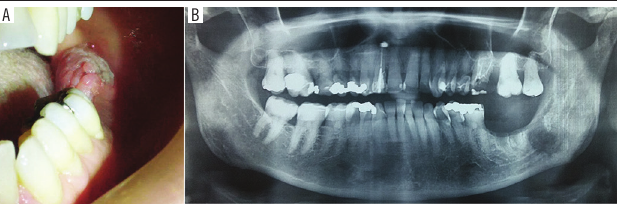
figurE 1 − A) exophytic mass located at the left mandibular gingiva. Previous dental extraction and chronic suppurative osteomyelitis were noticed in this area; B) panoramic radiograph showing an osteolytic area with irregular and ill-defined borders